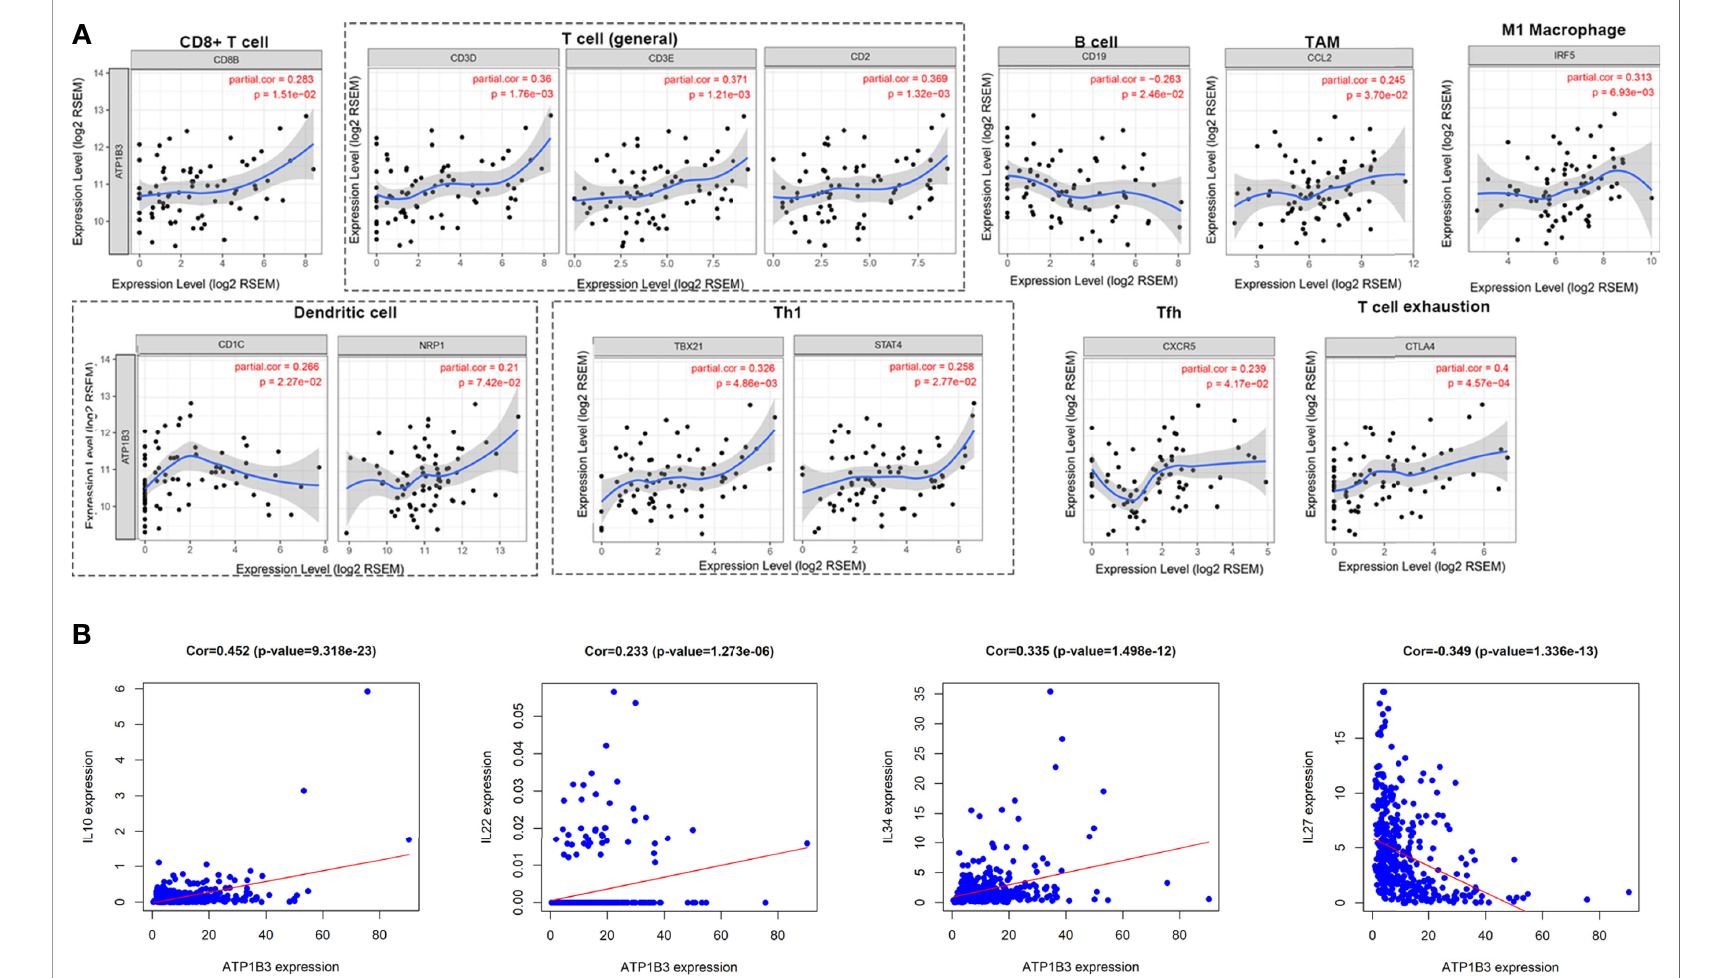
FIGURE 6 | Correlation between ATP1B3 and immune markers and immune-related cytokines in HCC. (A) The correlation between ATP1B3 and immune-related marker genes in HCC (TIMER). (B) The correlation between ATP1B3 and HCC-related